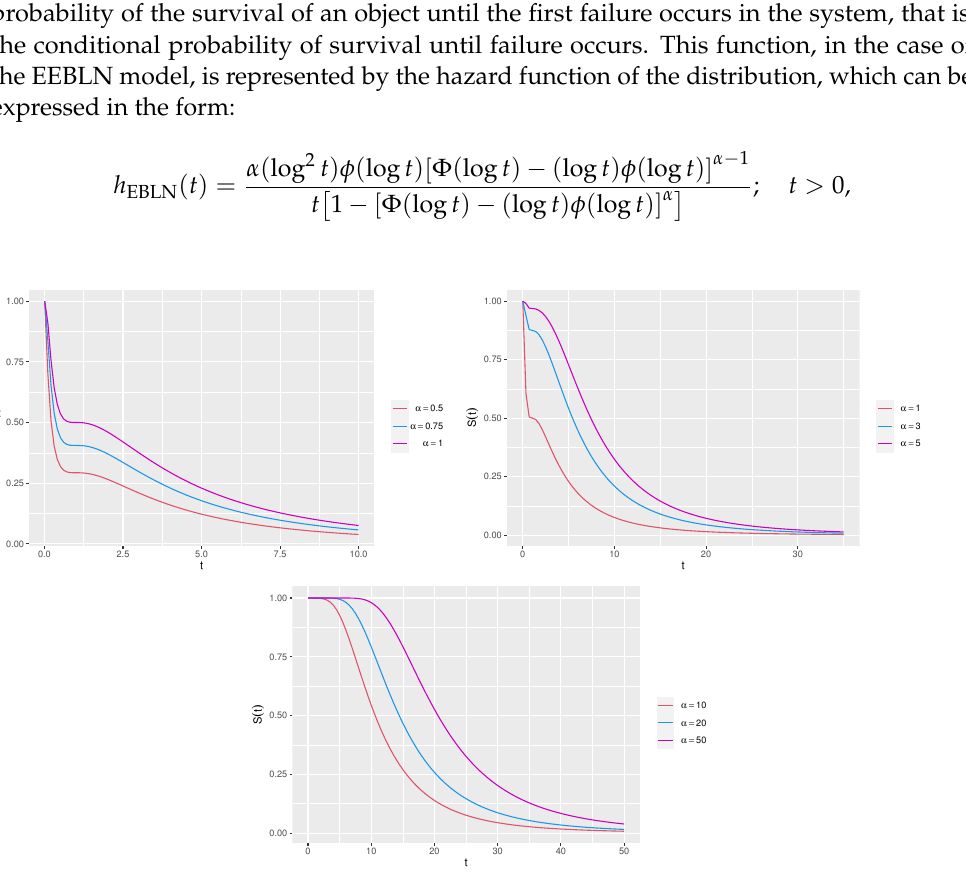
Figure 2. Survival function of the EBLN distribution for some selected values of α